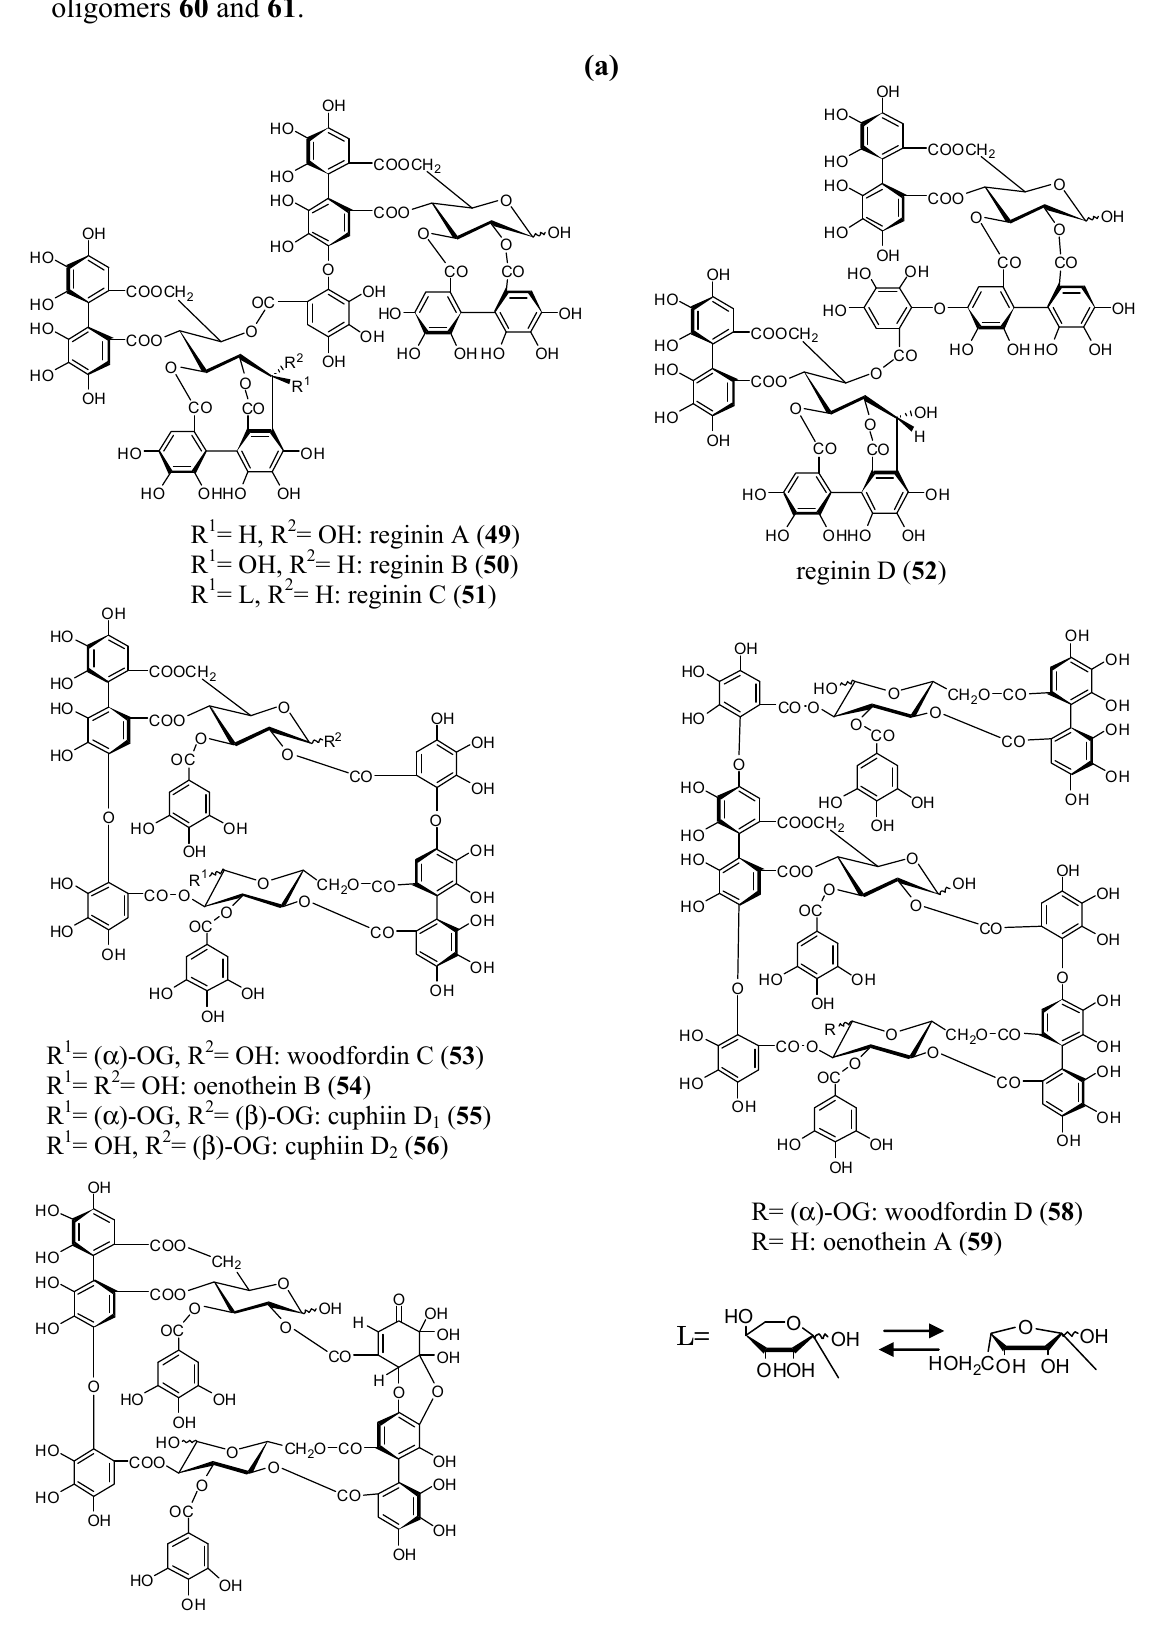
Figure 6. (a) Structures of ellagitannin oligomers 49 – 59 . (b) Structures of ellagitannin oligomers 60 and 61